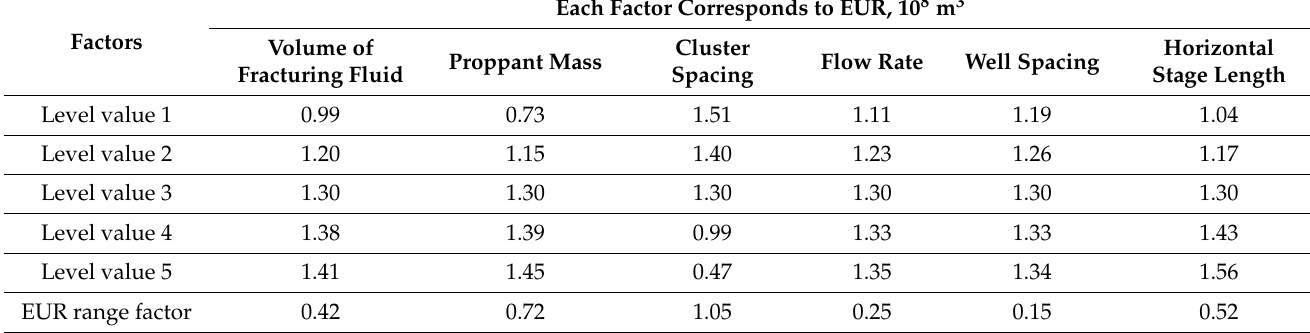
Table 2. Influence of engineering parameters on EUR.